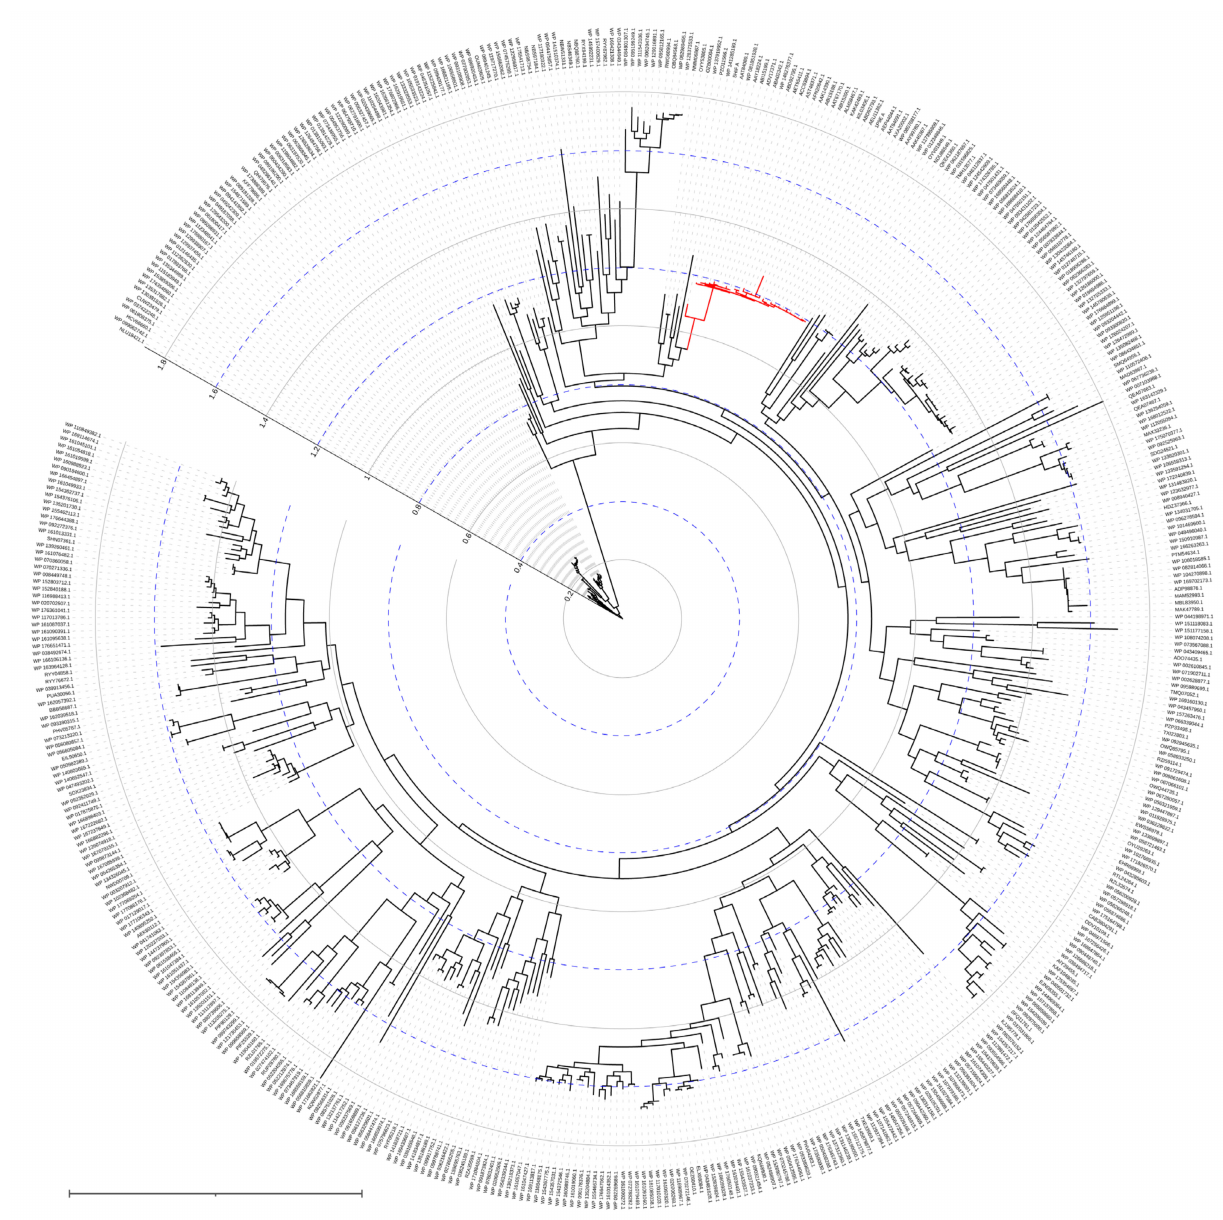
Figure 3. Phylogenetic tree of MPH and its homologous enzymes (down to 50% identity). The tree was built as previously with PDB 1P9E as a reference sequence. Enzymes having high identity (89–100%) are highlighted with